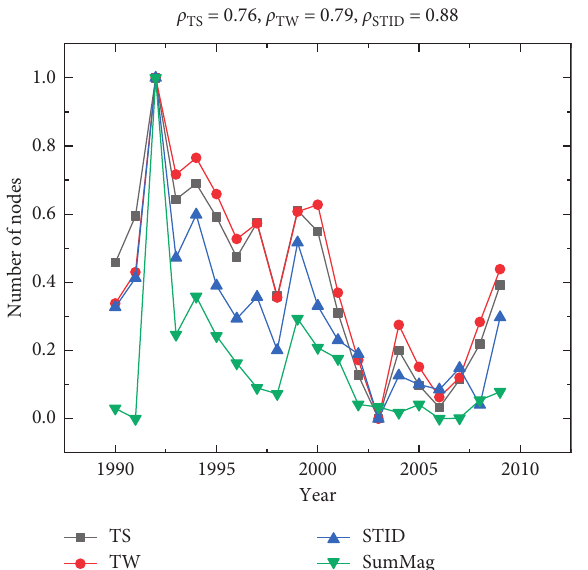
Figure 4: Evolution of the number of nodes of the networks constructed by TS, TW, and STID. SumMag represents the sum of earthquake